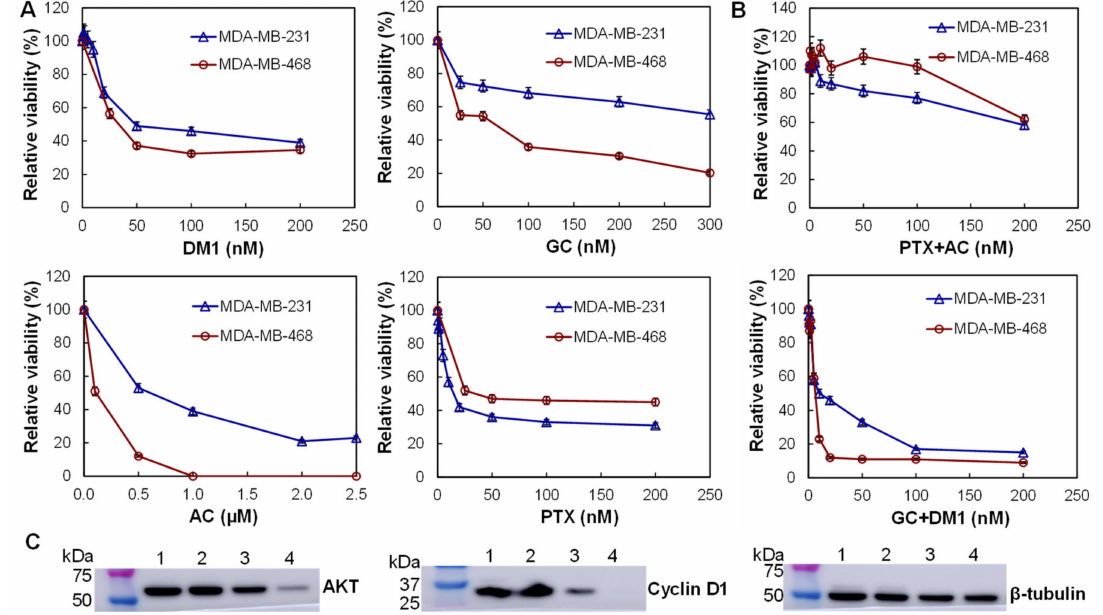
Figure 2. In vitro cytotoxicity and proliferation markers analysis. ( A ) The anti-TNBC cytotoxicity and dosage analysis of free drugs, i.e., mertansine (DM1), gemcitabine (GC), doxorubicin (AC), and paclitaxel (PTX), using human TNBC MDA-MB-231 cell line ( ∆ ) and MDA-MB-468 cell line ( ) (data represent mean ± SEM, n = 3). ( B ) Cytotoxicity analysis (cid:35) of the combined chemotherapies, i.e., PTX + AC and GC + DM1, in TNBC MDA-MB-231 cell line ( ∆ ) and MDA-MB-468 cell line ( ). ( C ) Western blotting analysis of proliferation and apoptosis biomarkers in MDA-MB-231 cells. 1: PBS control; (cid:35) 2: 5 nM GC and 20 nM DM1; 3: 20 nM GC and 50 nM DM1; 4: 200 nM GC and 200 nM